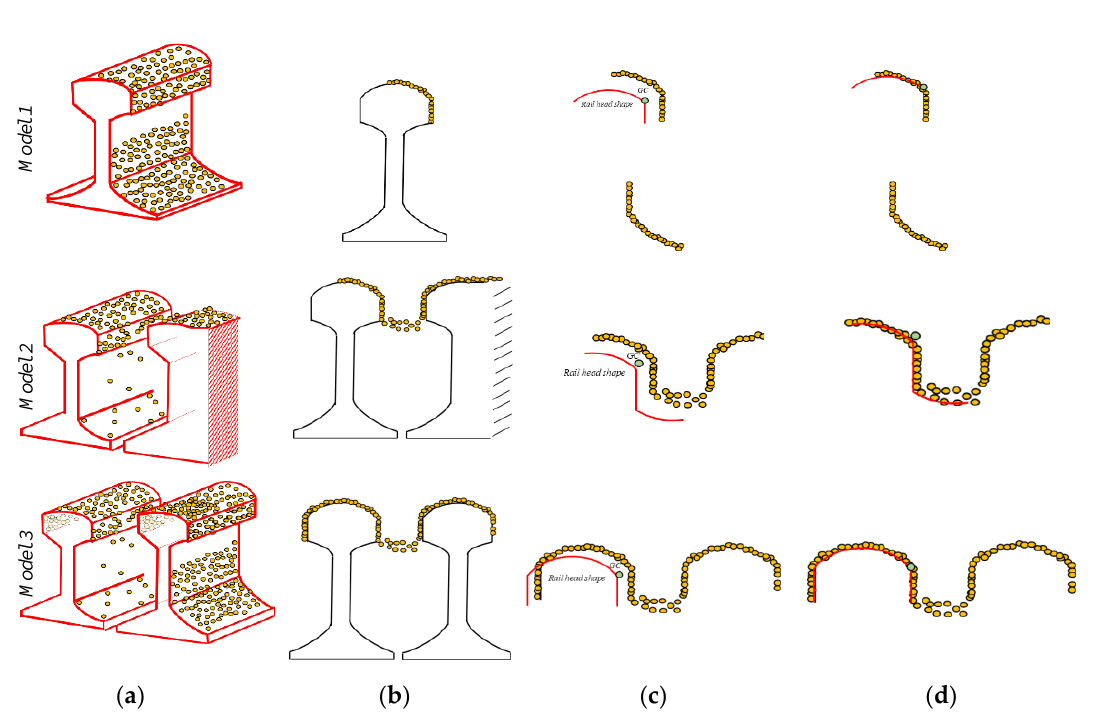
Figure 9. Spatial dispertion of ( a ) extracted point cloud in 3D plane ( b ) projected points in 2D plane, ( c ) proposed model fitting shapes ( d ) ICP applied ideal track in Model 1, level crossing in Model 2 and turnout in Model 3.